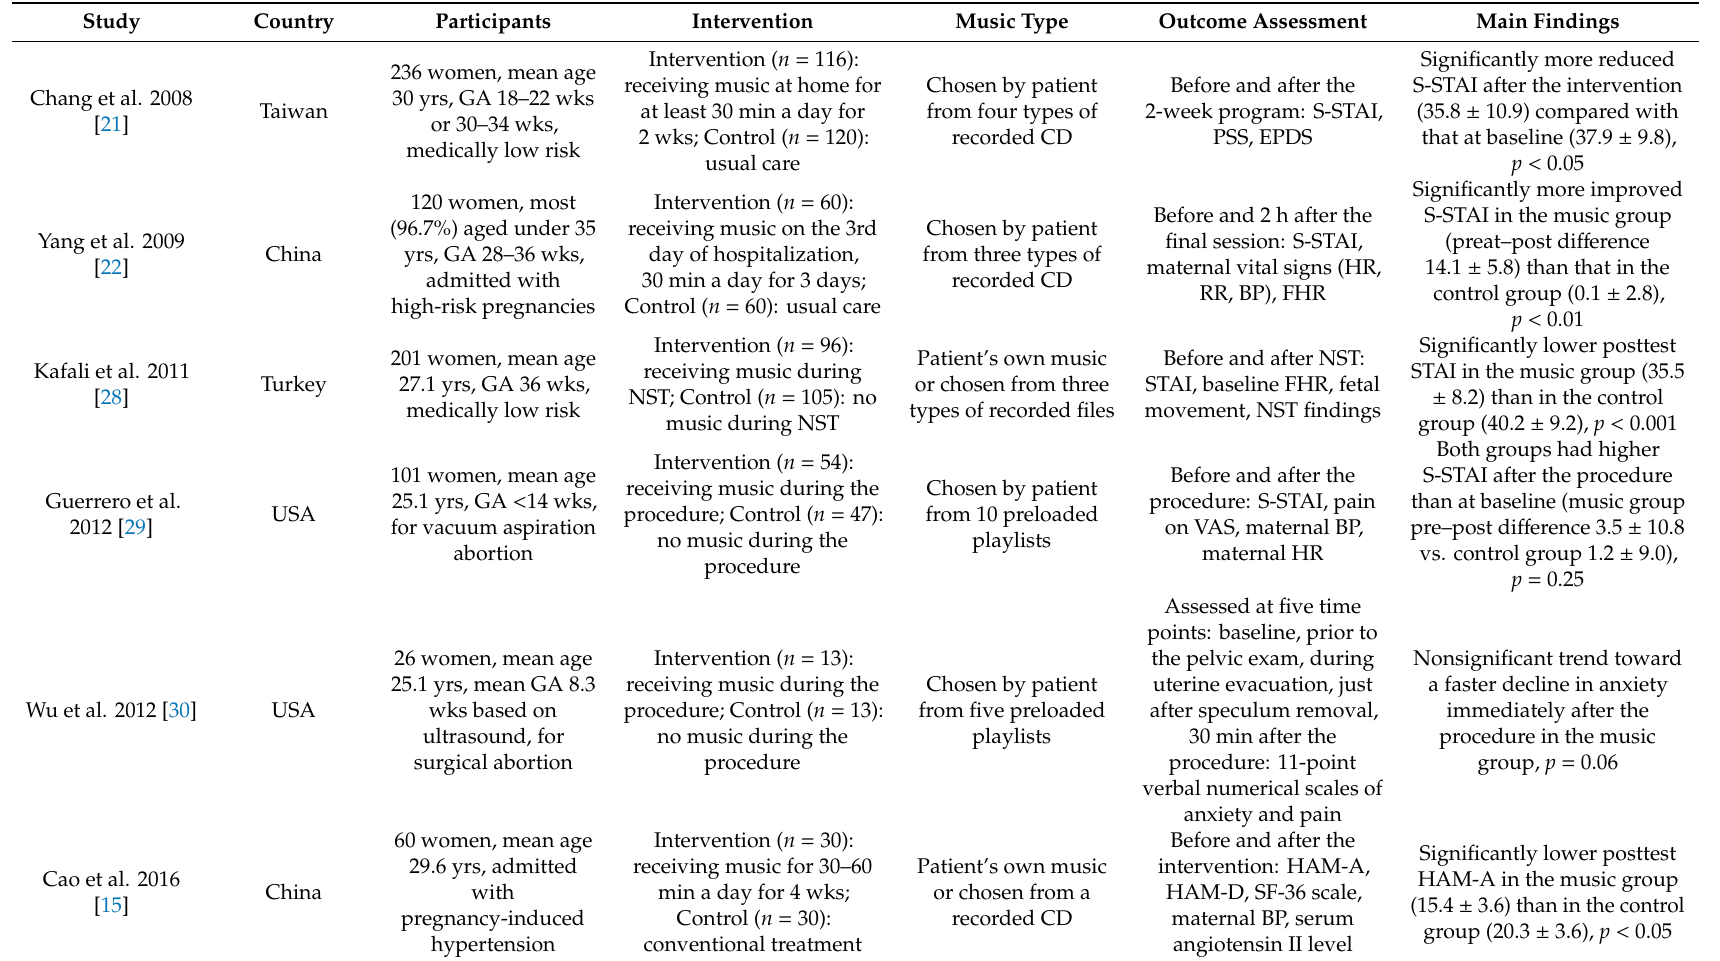
Table 1. Characteristics of the included